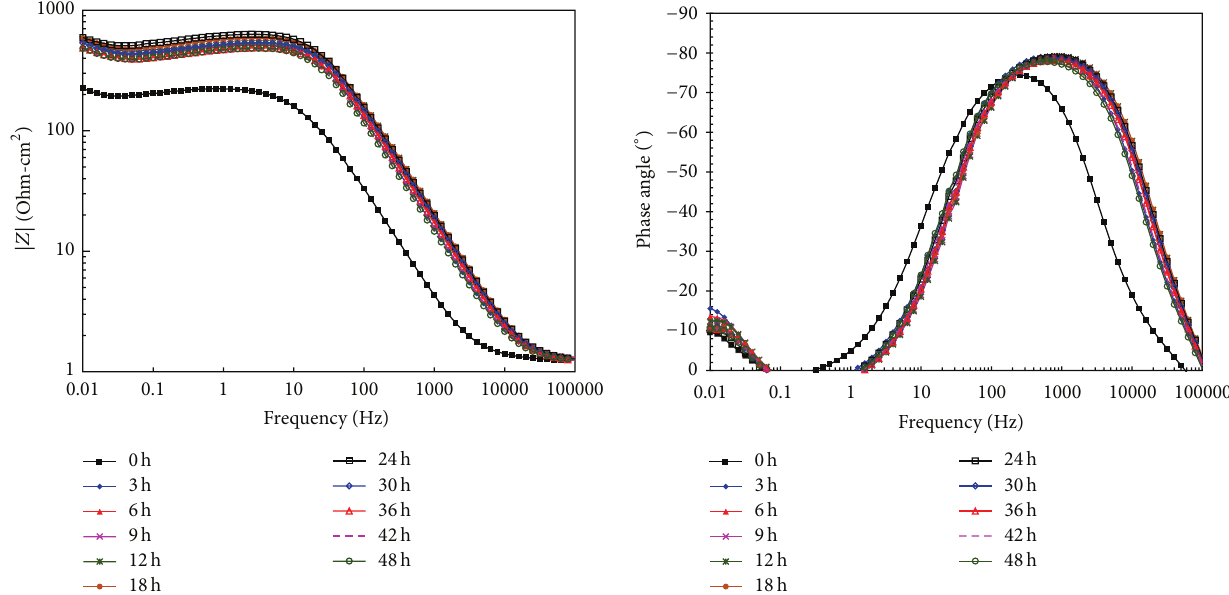
Figure 7: Bode plots for aluminum in 1.0M H 2 SO 4 solution at 25 ∘ C.